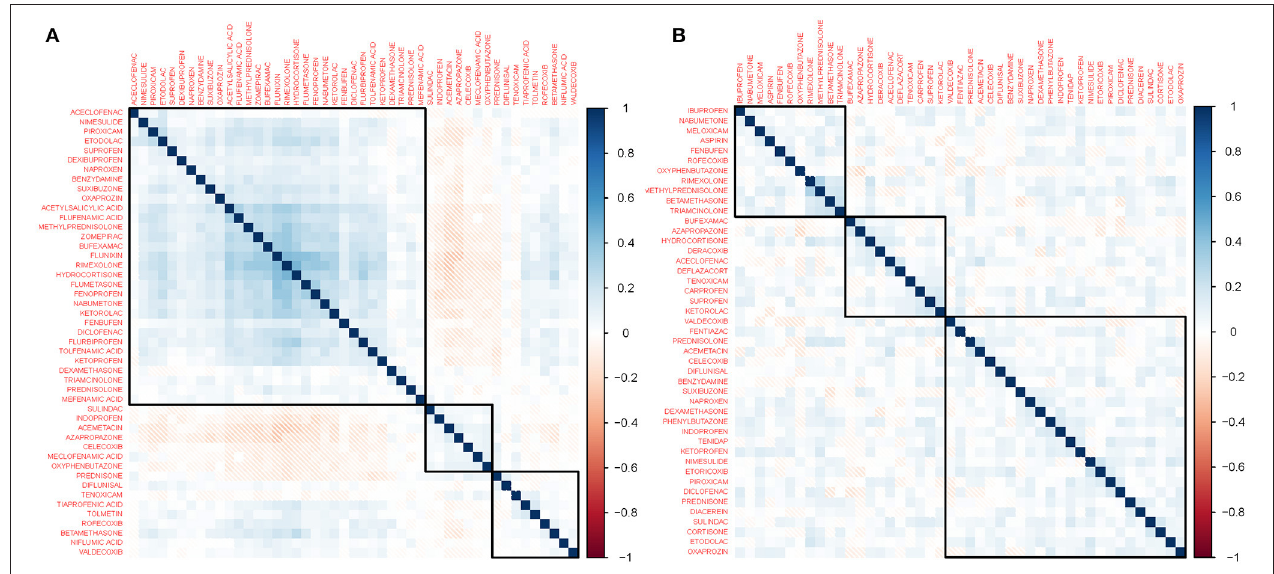
FIGURE 3 | Heatmap of gene perturbation similarity. These heatmaps represent similarities in gene expression profiles induced by drugs obtained from the (A) Connectivity Map (CMap) and (B) Library of Integrated Network-based Cellular Signatures (LINCS) datasets. The color intensity is proportional to the similarity between the gene expression profiles of two drugs measured using the Spearman correlation. Drugs are ordered using non-supervised hierarchical clustering. In both panels, a larger cluster containing most drugs and two smaller clusters are shown. The clusters comprise drugs that do not necessarily share structural similarities.